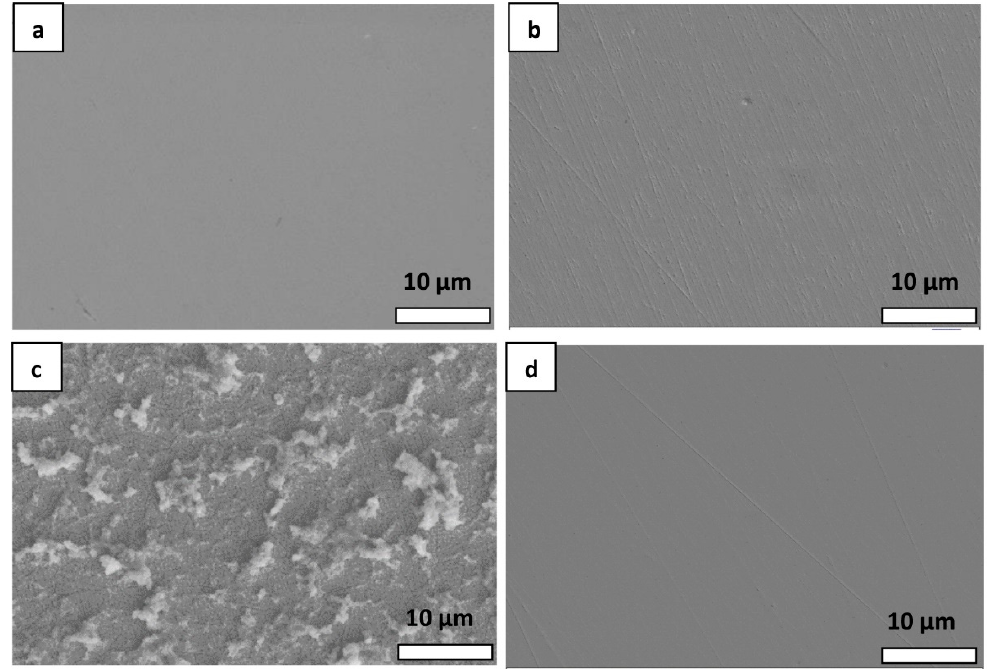
Figure 5. SEM images of Cu-5Zn-5Al-1Sn alloy before ( a ) and after immersion in 3.5 wt.% NaCl, without ( b ) and with 10 − 4 M of cysteine ( c ) and 10 − 2 M cysteine ( d ), respectively.